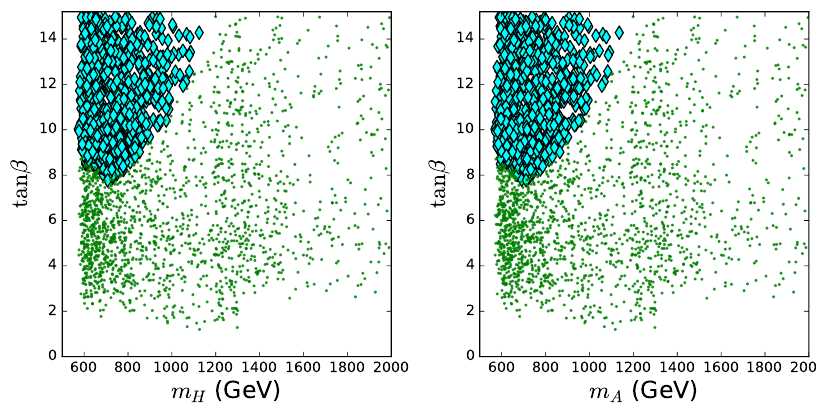
Figure 8 . In the type-II model, all the surviving samples satisfies the constraints of pre-inflation, h 2 -inflation, the exclusion limits from searches for Higgs at LEP, the flavor observables, and R b . The diamonds (cyan) are excluded by H/A → τ + τ − channels at the LHC, and the bullets (green) are allowed by various LHC direct searches.